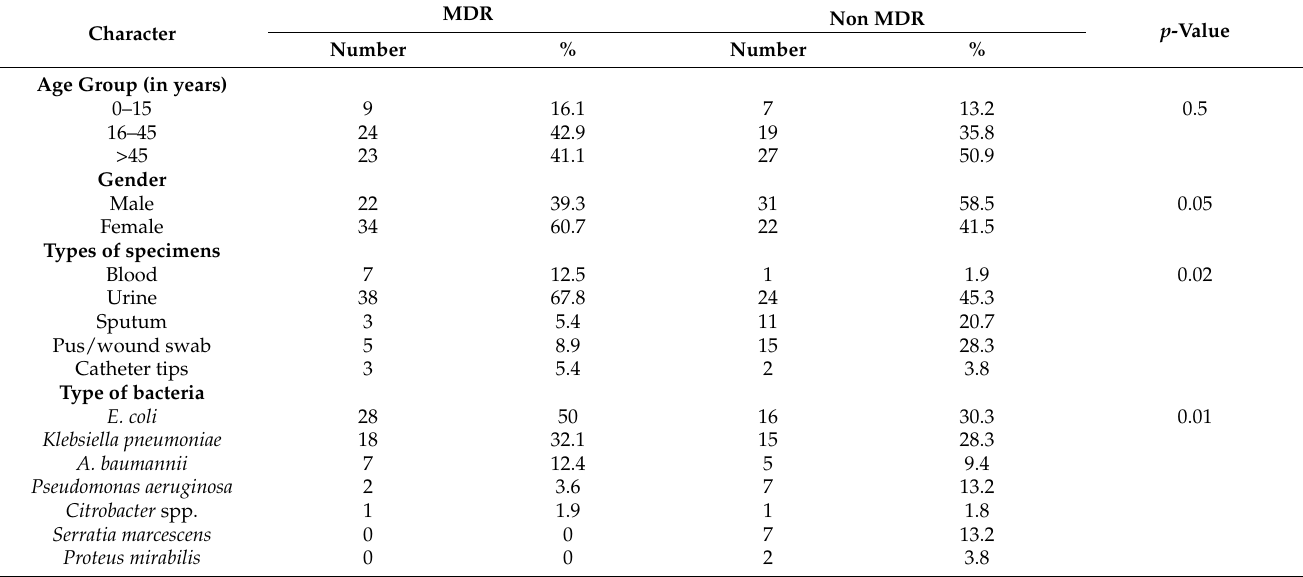
Table 3. Prevalence of MDR in Gram-negative bacteria according to demographic characteristics ( n = 109).